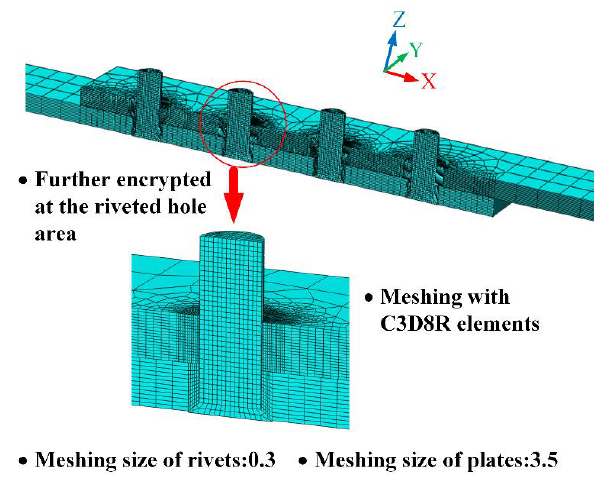
Figure 7. The meshing of the simulation model. The C3D8R elements are used and the riveted hole area is further encrypted.